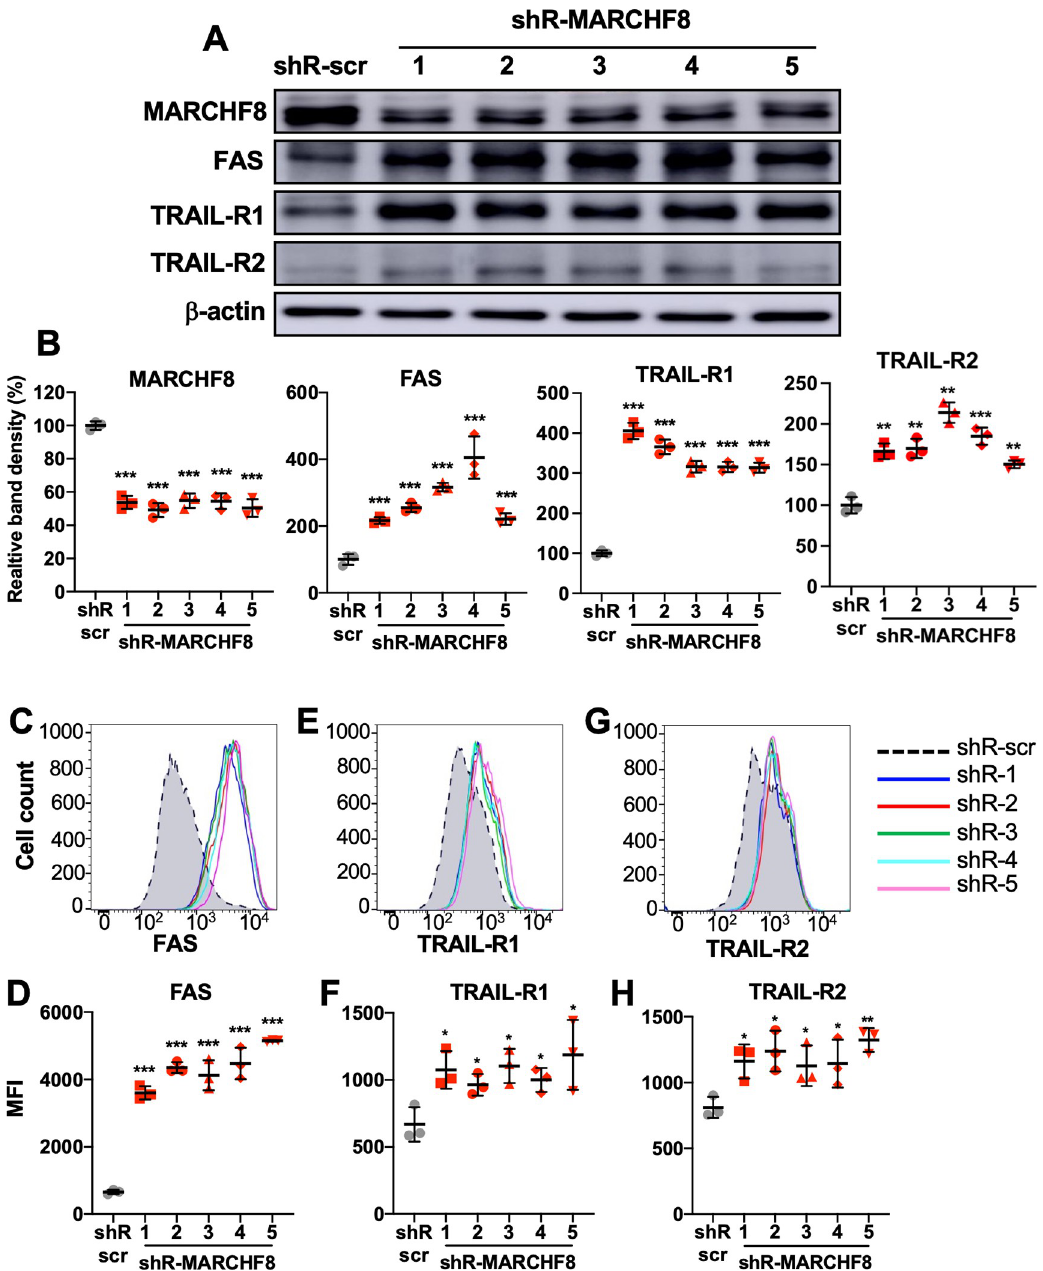
Fig 4. Knockdown of MARCHF8 expression increases FAS, TRAIL-R1, and TRAIL-R2 protein expression in HPV+ HNC cells. HPV+ HNC (SCC152) cells were transduced with one of five lentiviral shRNAs against MARCHF8 (shR-MARCHF8 clones 1–5) or scrambled shRNA (shR-scr) as a control. Protein expression of MARCHF8, FAS, TRAIL-R1, and TRAIL-R2 was determined by western blotting ( A ). Relative band density was quantified using NIH ImageJ ( B ). β -actin was used as an internal control. The data shown are means ± SD of three independent experiments. Cell surface expression of FAS ( C and D ), TRAIL-R1 ( E and F ), and TRAIL-R2 ( G and H ) proteins were analyzed by flow cytometry. Mean fluorescence intensities (MFI) of three independent experiments are shown ( D , F , and H ). P values were determined by Student’s t -test. � p < 0.05, �� p < 0.01, ��� p <